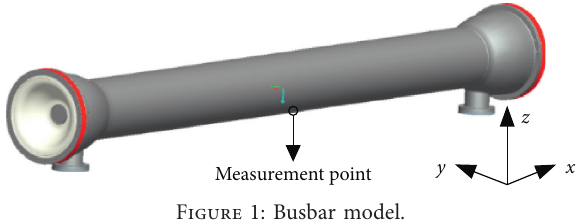
Figure 1: Busbar